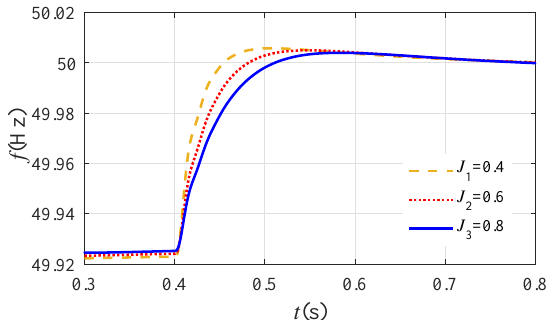
Figure 15. Frequency response under different virtual inertia when connected to the grid.